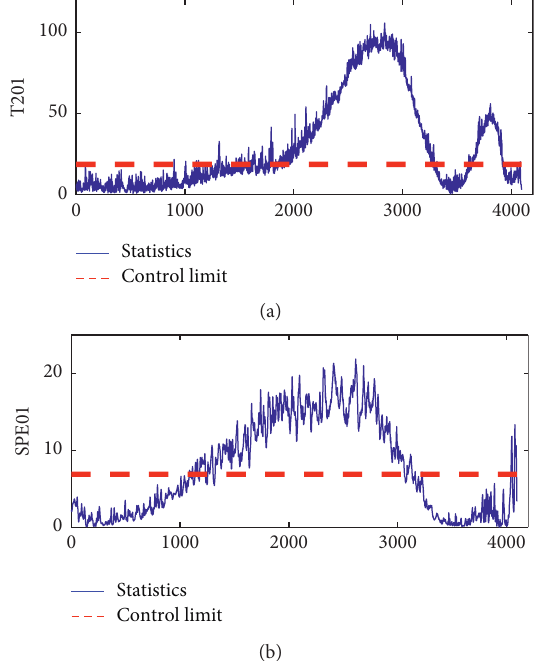
Figure 7: Case Western Reserve University bearing outer ring failure results based on EMD-PCA.